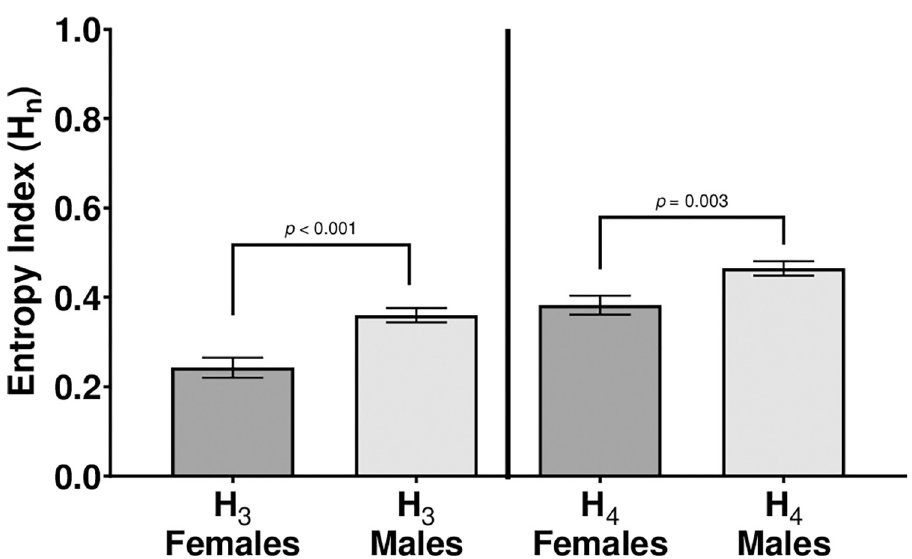
Fig 7. Sex differences in behavioral entropy. H 3 measures entropy across three vertical zones while H 4 measures entropy across four quadrants. Error bars are +/- SEM . While exact p- values are reported for post-hoc comparisons, p- values smaller than 0.001 are indicated as p <